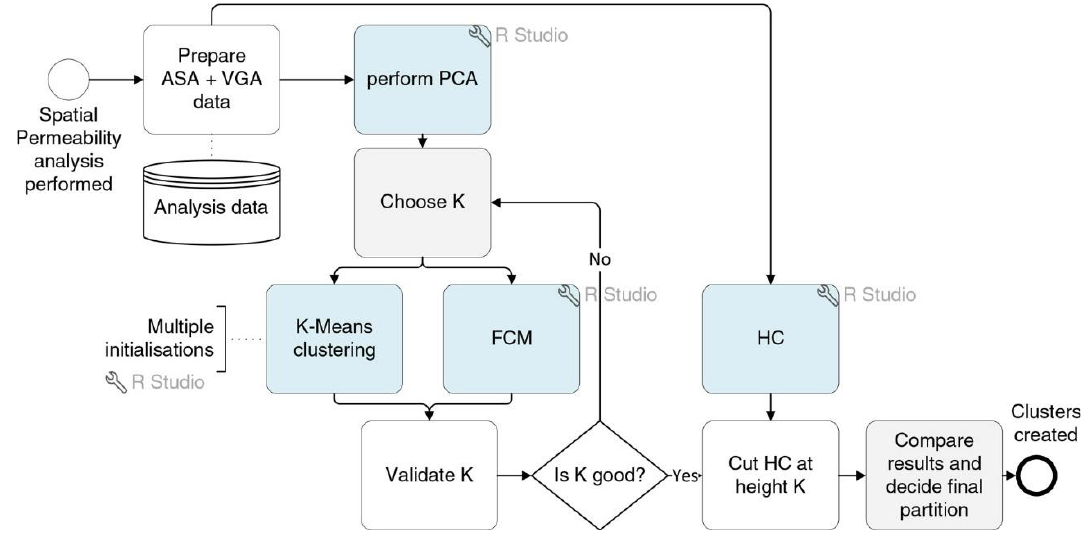
Figure 3 Cluster analysis methodology, including HC, K-Means and